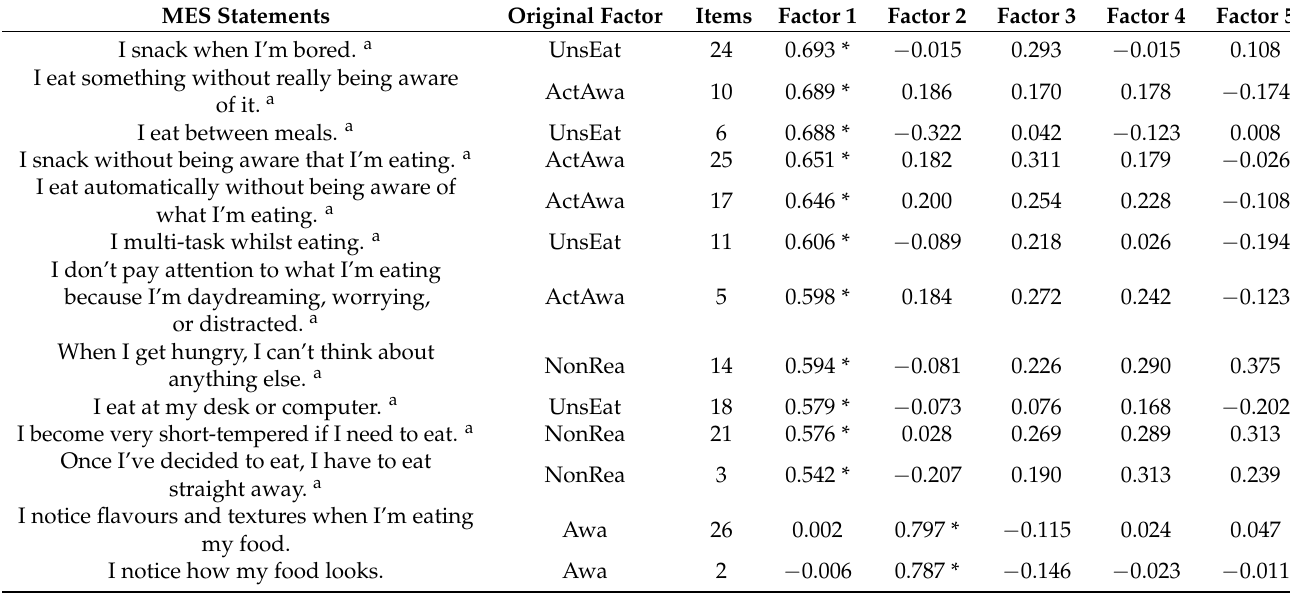
Table 6. Component loadings for MES